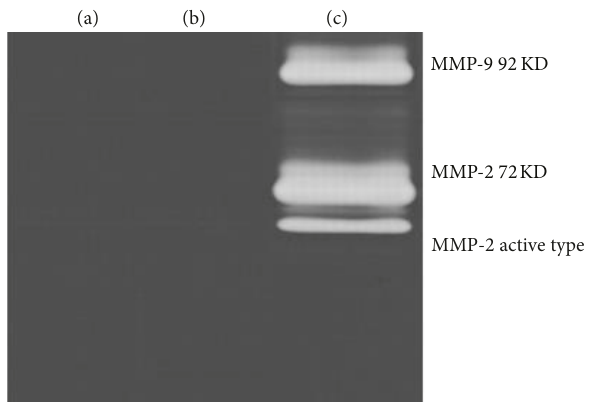
Figure 8: MMP-2 and MMP-9 expressions were detected by gelatin gel zymography. MMP-2 and MMP-9 expression in microencapsu- lated SGC7901 cells (a), macrophages (b), and microencapsulated SGC7901 cells cocultured with macrophages